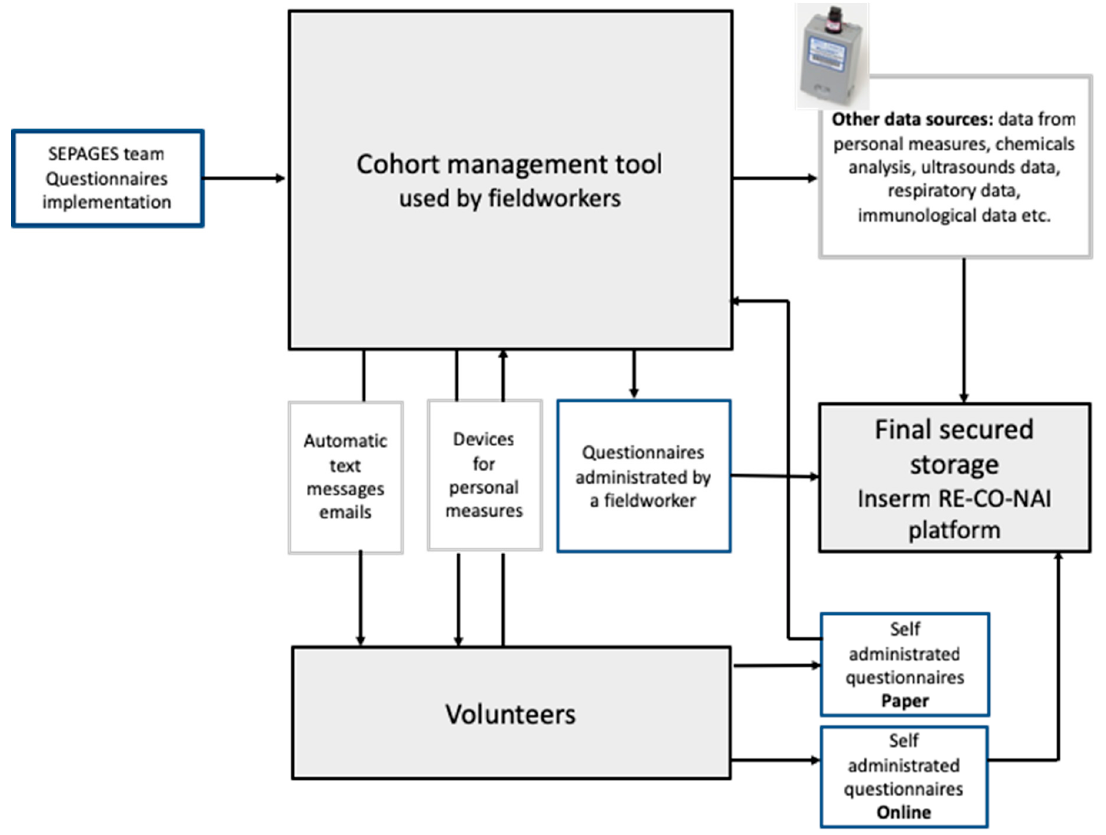
Figure 5. Data collection and storage platform structure for a paper-free cohort.